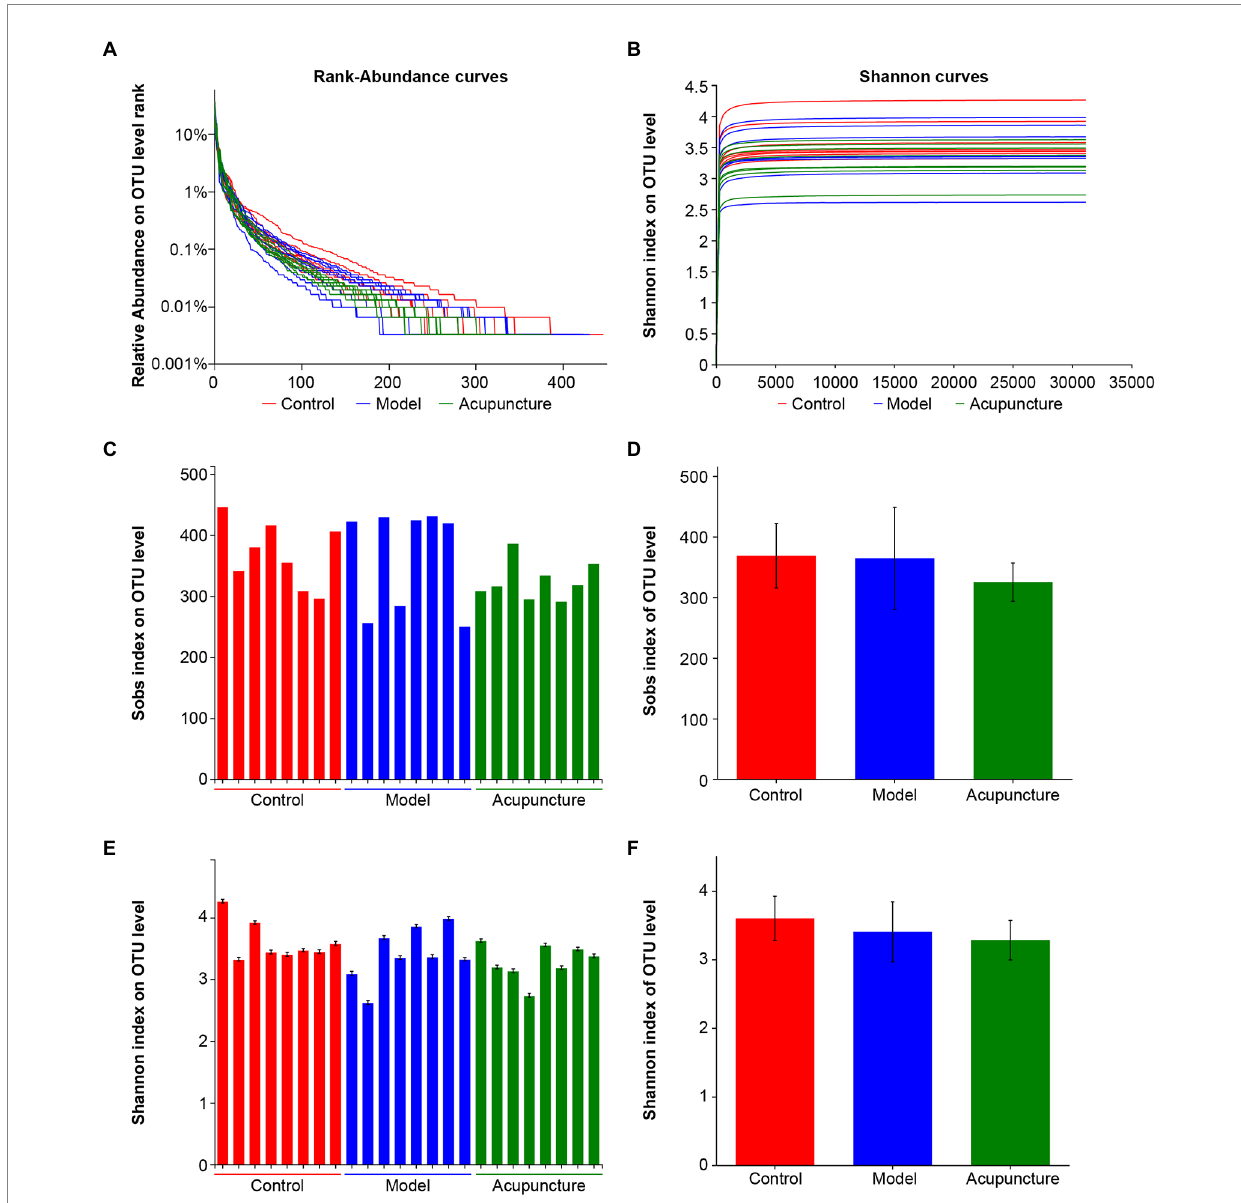
FIGURE 4 Sample sequencing results and species diversity analysis. (A) Rank-abundance curves indicating species diversity, including richness and evenness. Species richness is represented by the width of the curve. The larger the curve range on the horizontal axis, the higher the species richness; the smoother the curve, the more community evenness. (B) Rarefaction curve of Shannon index at the OTU level. (C) Alpha diversity of Sobs index at the OTU level indicating community richness. (D) Statistical analysis of the Sobs index at the OTU level. (E) Alpha diversity of the Shannon index at the OTU level indicating community diversity. (F) Statistical analysis of the Shannon index at the OTU